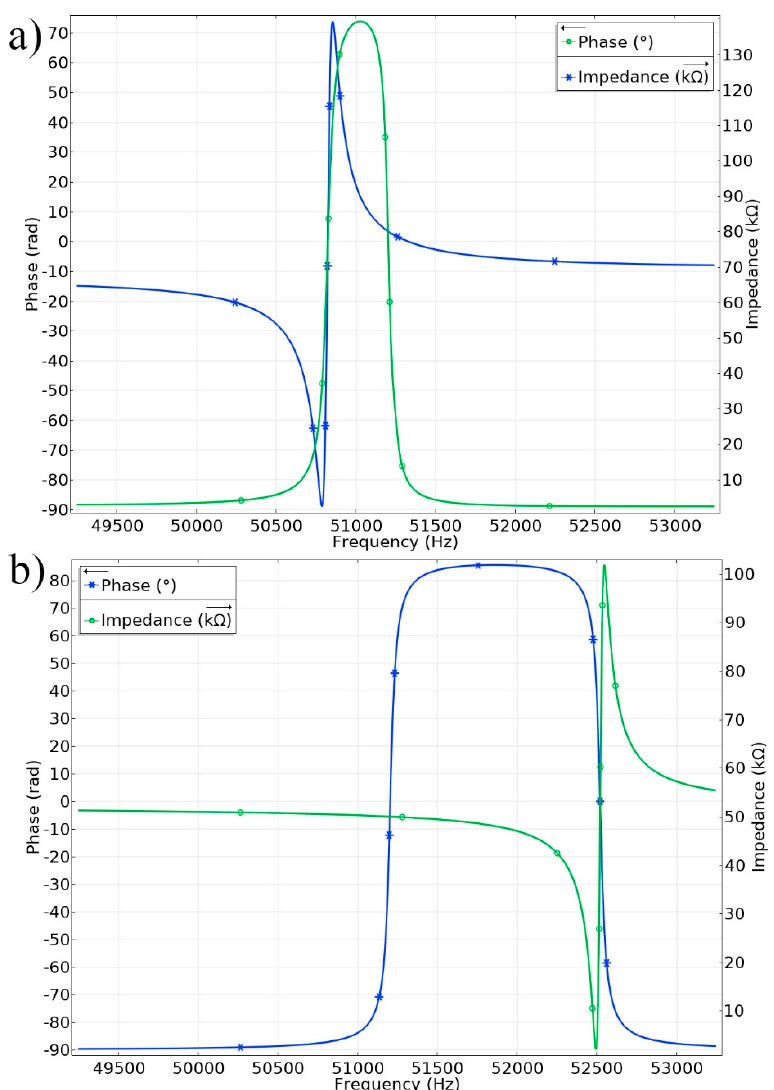
Figure 4. Impedance–frequency and phase–frequency characteristics of the actuator: ( a ) the characteristics of the first longitudinal vibration mode; ( b ) the characteristics of the second bending vibration mode .